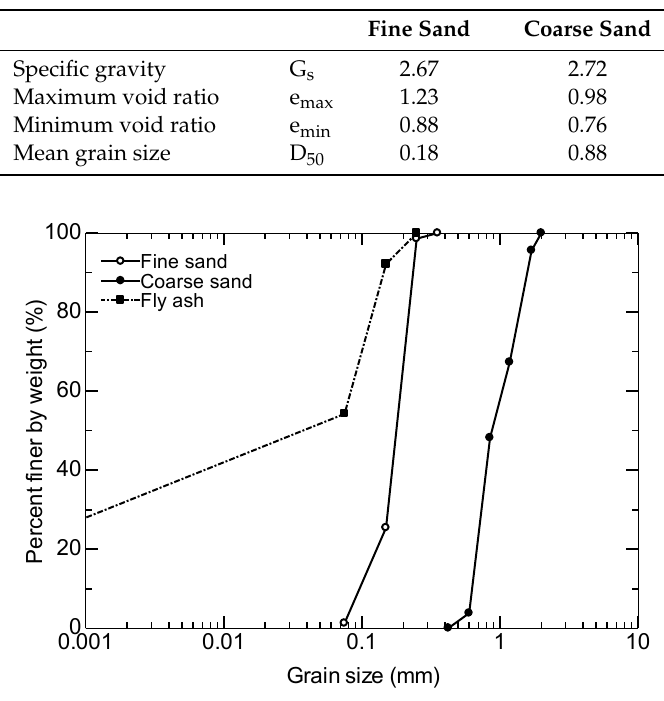
Figure 1. The grain size distribution of the studied sand.